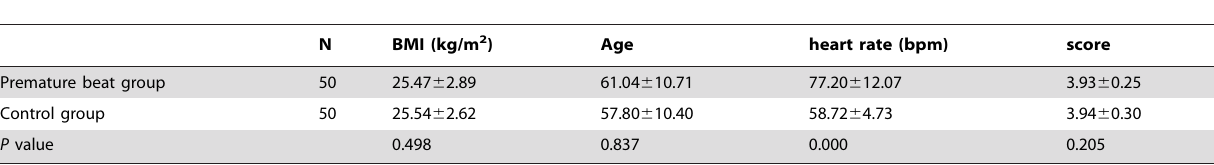
Table 5. Comparison of statistical results of variable parameters in the premature beat group and the control group.